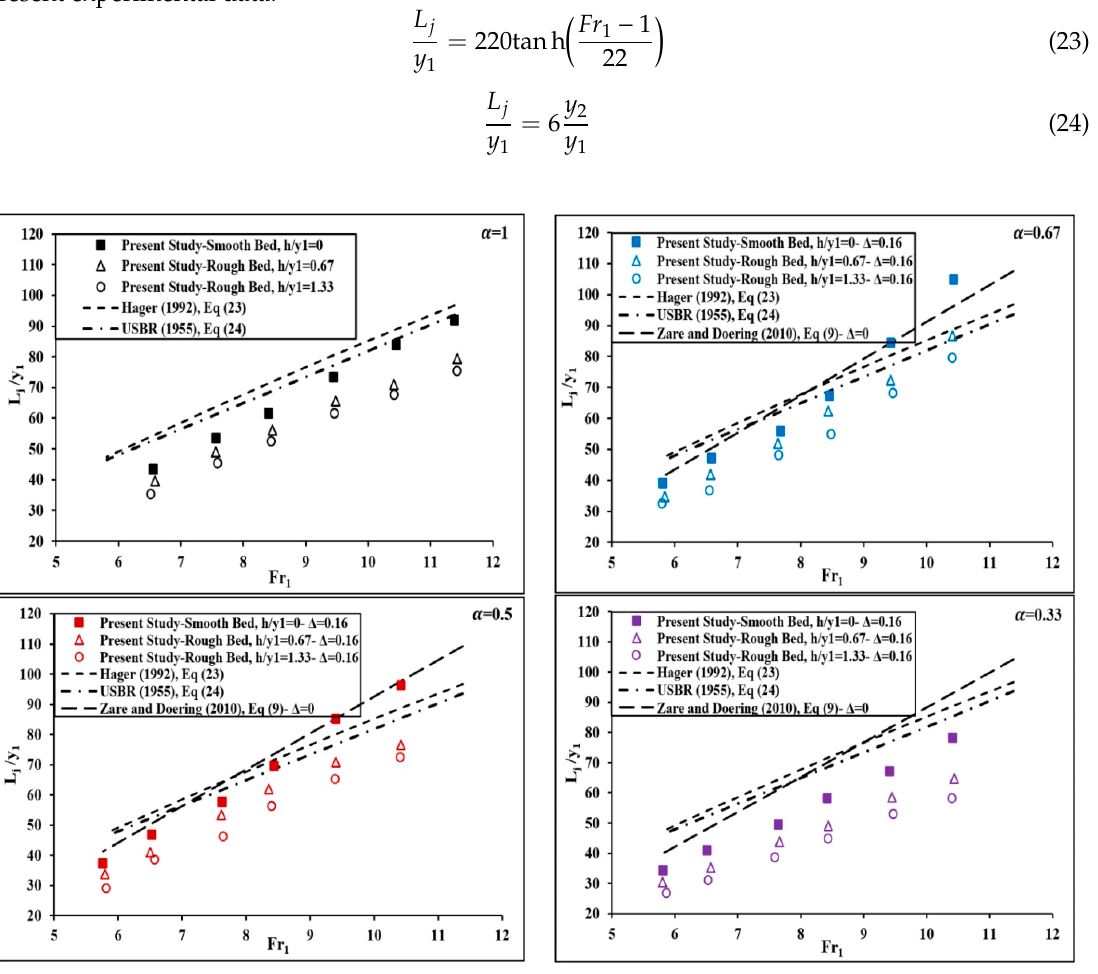
Figure 10. Relative length of the hydraulic jump as a function of upstream Froude number for two relative roughness heights ( h / y 1 = 0.67 and 1.33) and di ff erent expansion ratios ( α = 0.33, 0.5, 0.67, 1) with asymmetry ratio of ∆ = 0.16.